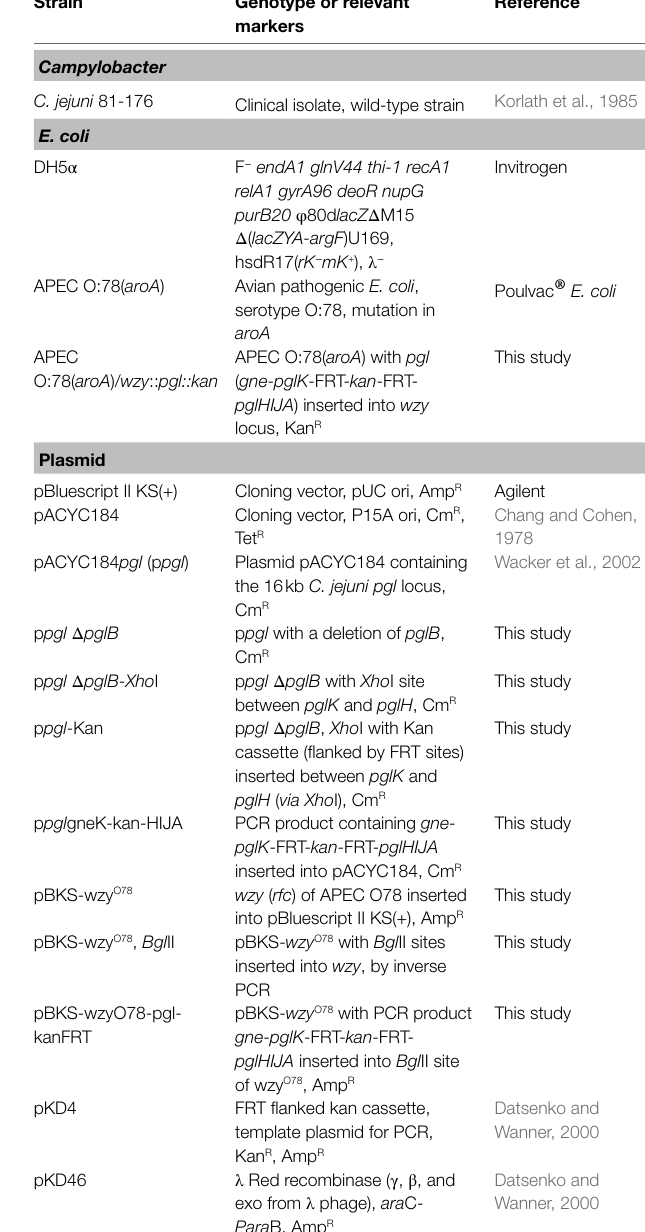
TABLE 2 | Strains and plasmids.